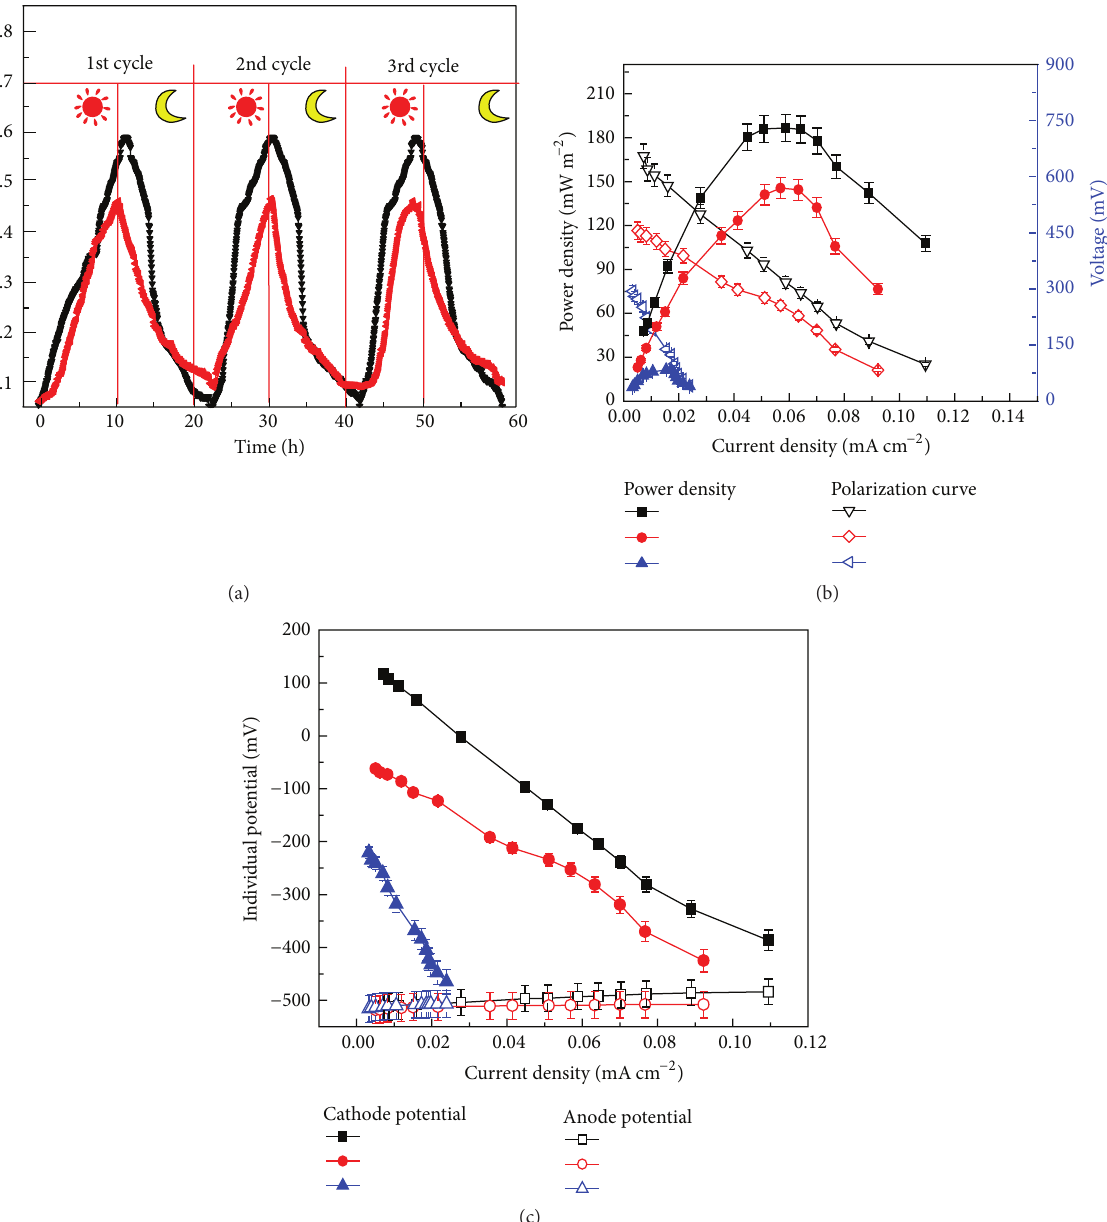
Figure 2: (a) Potential changes of the MCCs under different circumstances (black line is when CO 2 travelled through the silicon tube and red line is when CO 2 travel through the silicon tube was blocked with a clip. The symbols of moon and sun represent dark and light conditions, resp.). (b) Power density and polarized curves of the MCCs operated under various conditions. (c) Individual cathode and anode potentials versus current density curves (black line: CO 2 travelled through the tube under light illumination; red line: CO 2 travel through the silicon tube was blocked under light illumination; blue line: CO 2 travelled through the silicon tube in the dark).